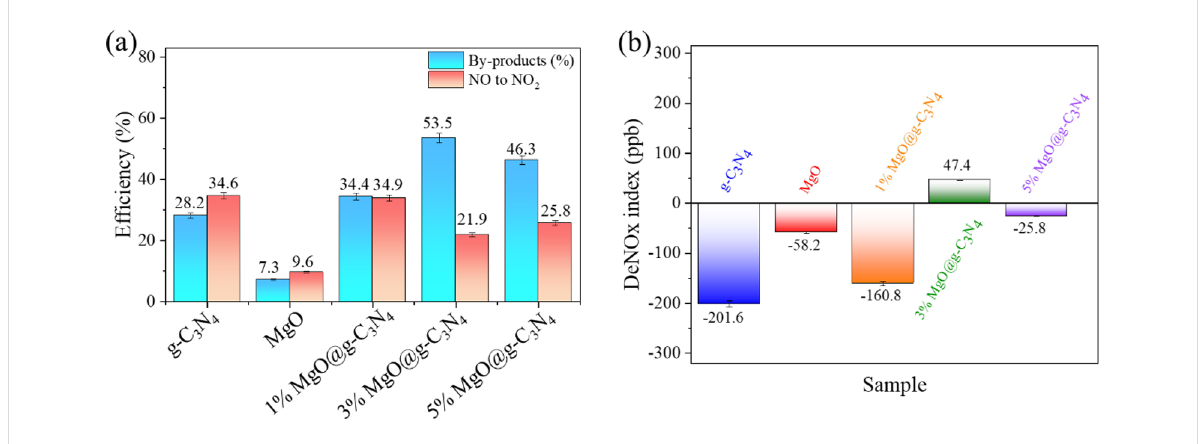
Figure 3: (a) NO conversion and (b) DeNOx index of the materials.